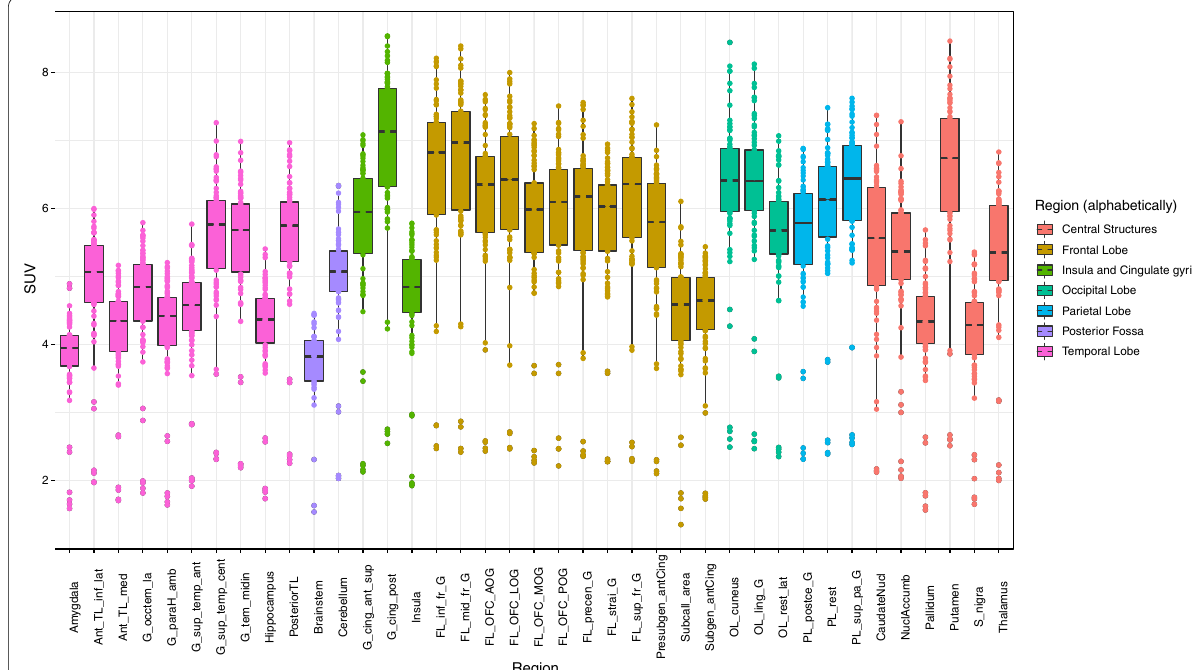
Fig. 3 Boxplot of regional SUV for all subjects in the database. Centre lines correspond to medians, boxes to interquartile ranges, and whiskers to robust ranges. Outliers are represented as dots. Each dot represents a participant for unpaired regions and a participant’s right or left SUV value for paired